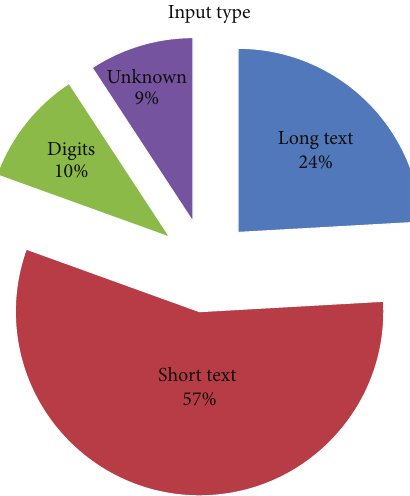
Figure 4: The percentage distribution of various types of input